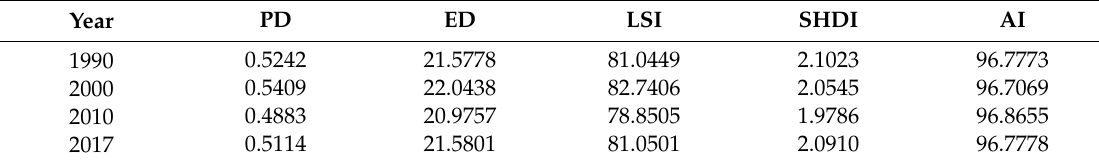
Table 5. Calculation results of landscape pattern index in the whole study area.